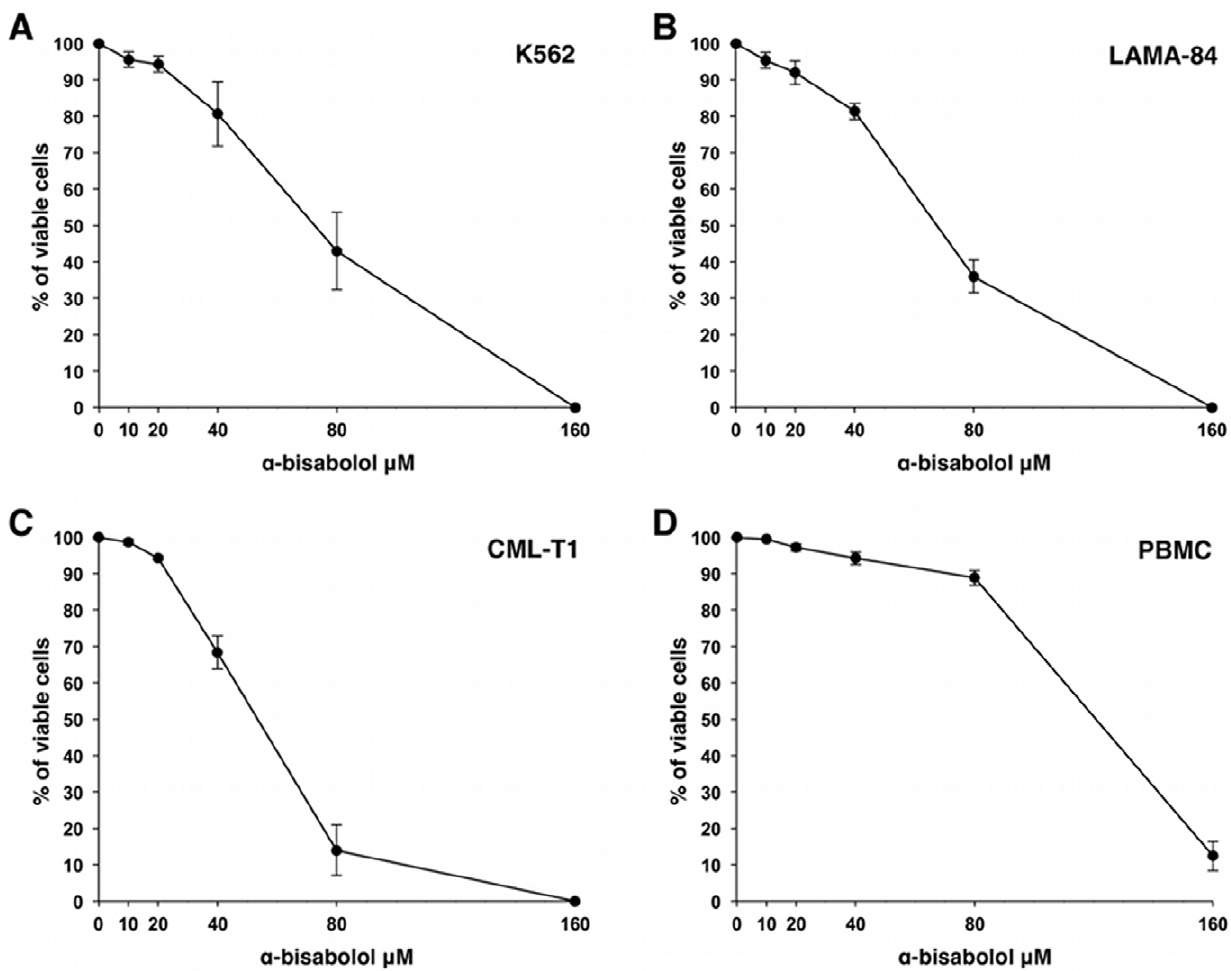
Figure 1. a -bisabolol reduced BCR-ABL + cell viability. (A-C) Cell lines were treated with a -bisabolol at the indicated concentration for 48 hours. Results are expressed as mean 6 SD of 5 experiments for each cell line. (D) Normal PBMC (n=5), in the same experimental conditions, are significantly less sensitive to a -bisabolol (p=.03).